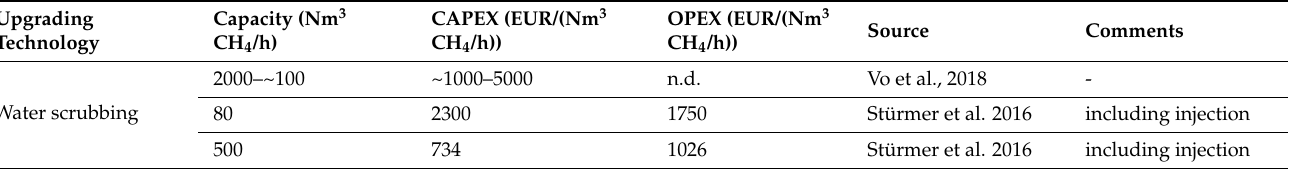
Table 8. CAPEX and OPEX of biogas upgrading by technology and scale of production (measured by